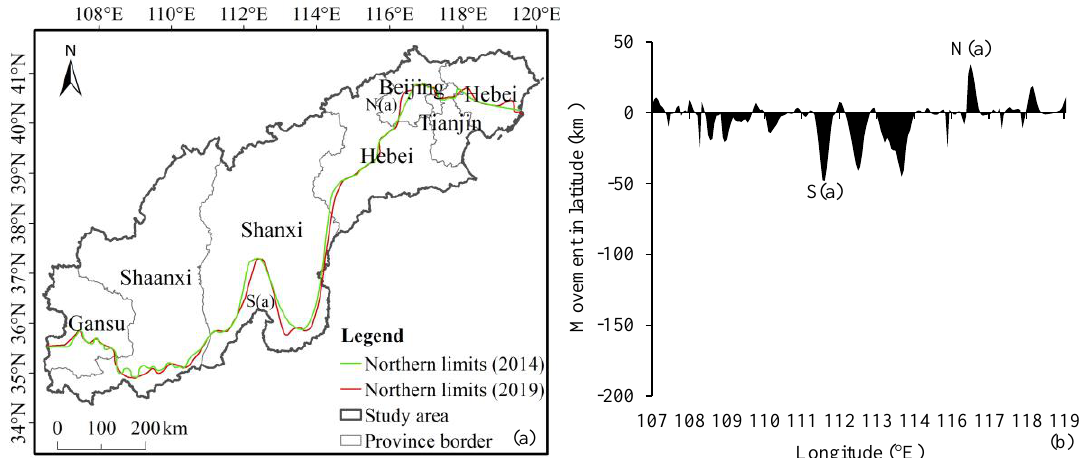
Figure 11. ( a ) Derived extent of the NLWW and ( b ) latitudinal movement of the NLWW during the period 2014–2019. (Red solid lines show NLWW at end of period, green solid lines show NLWW at beginning of period, black bars indicate latitudinal movement of NLWW, S(a) represent typical points of southward migration, and N(a) represent typical points of northward migration.).